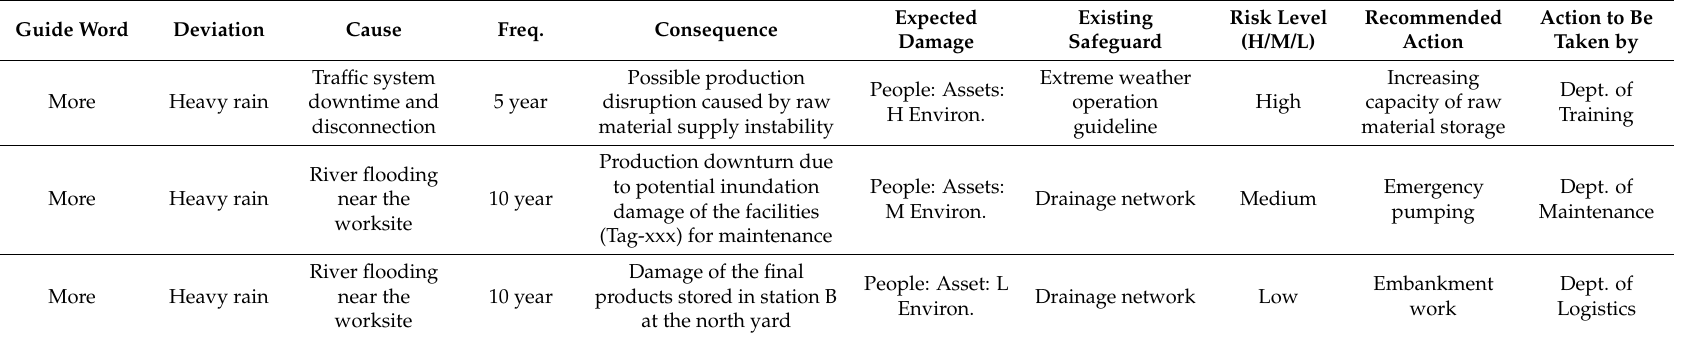
Table 3. A sample HAZOP worksheet to identify risks associated with the parameter of rain for the service node of